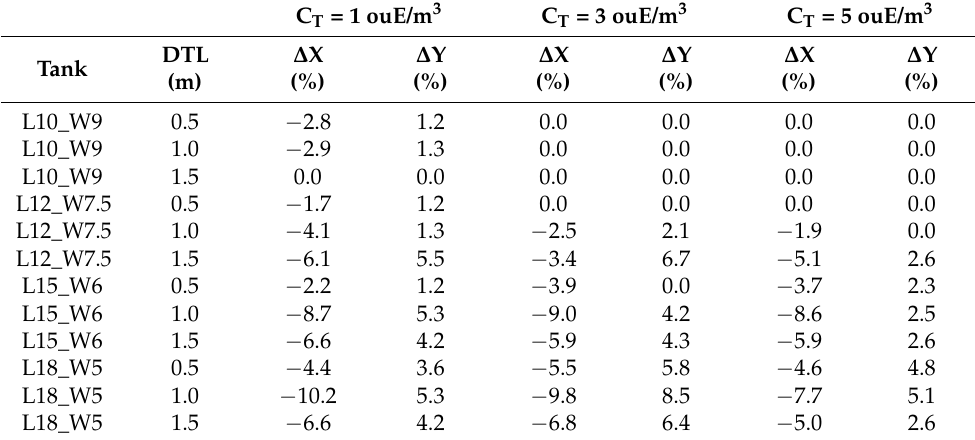
Table 8. Relative variation (%) of the maximum separation distances along X and Y as a function of the tank